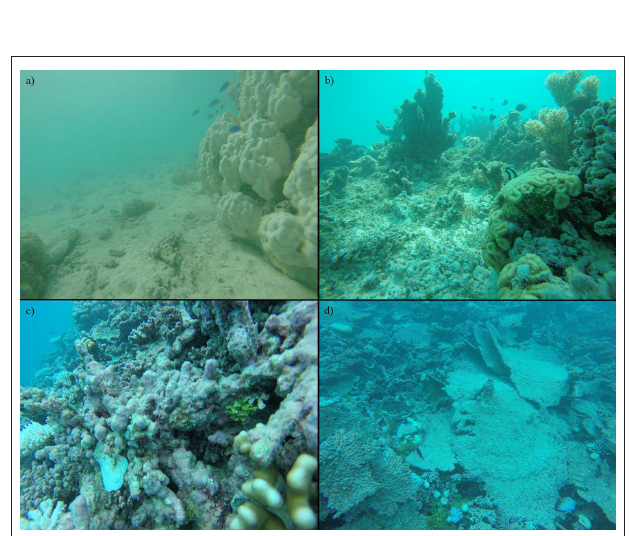
FIGURE 4 | Images of the dominant habitat types (a) Bleached coral Bommie on sand in Diego Garcia (b) Examples of living coral in Salomon (c) Bleached coral encrusted with coralline algae in Peros Banhos (d) Broken bleached table coral in Peros Banhos.